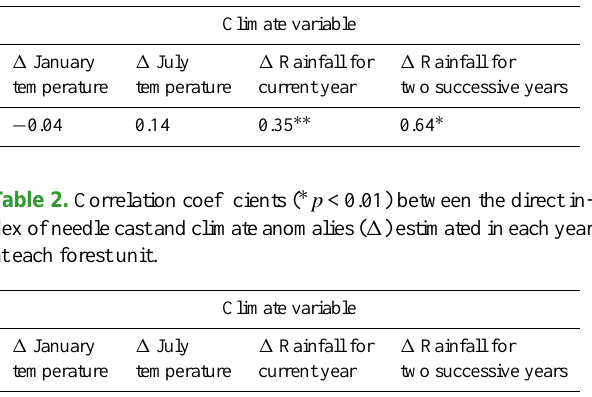
Table 1. Correlation coefficients ( ∗ p <0.05, ∗∗ p <0.2) between the normalized index of needle cast and climate anomalies ( (cid:49) ) aver- aged over the study area in each year.